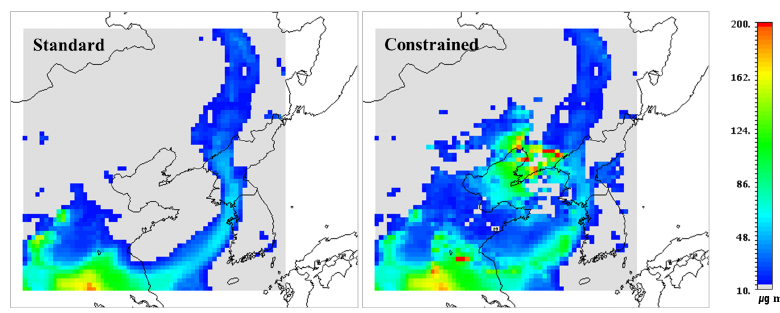
Figure 8. Difference of the simulated PM 10 concentrations (µgm − 3 ) between the standard CMAQ run (left) and STOPS forecasting run with alternative emissions estimated according to GOCI-derived AOD (right) inside the STOPS domain at 12:00LST on 22 February 2015. Table 3. Specific fractions (%) for the splitting of total PM emission into specific PM species in the CB05–AERO6 chemical mechanism used in this study.